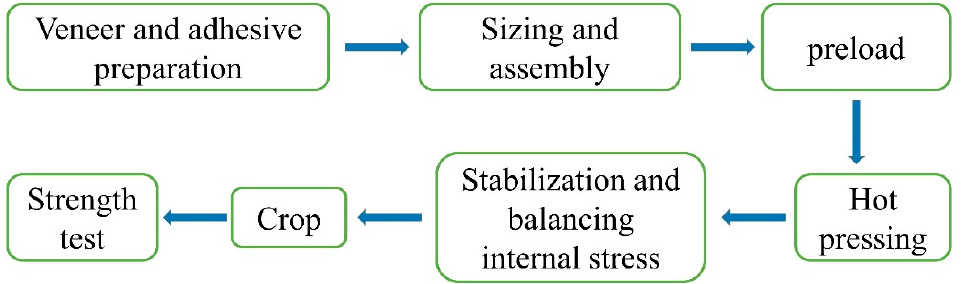
Figure 1. Flow chart of plywood production.